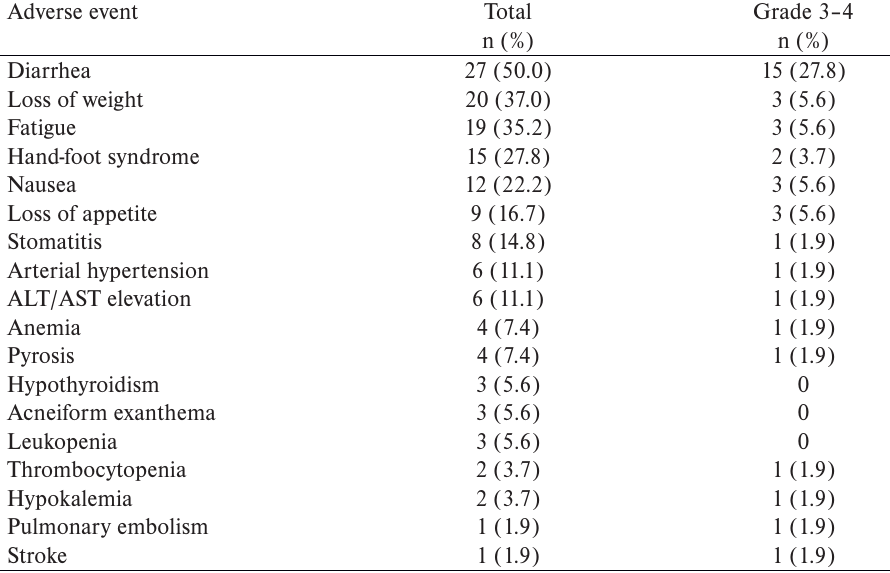
Table 4. Summary of adverse